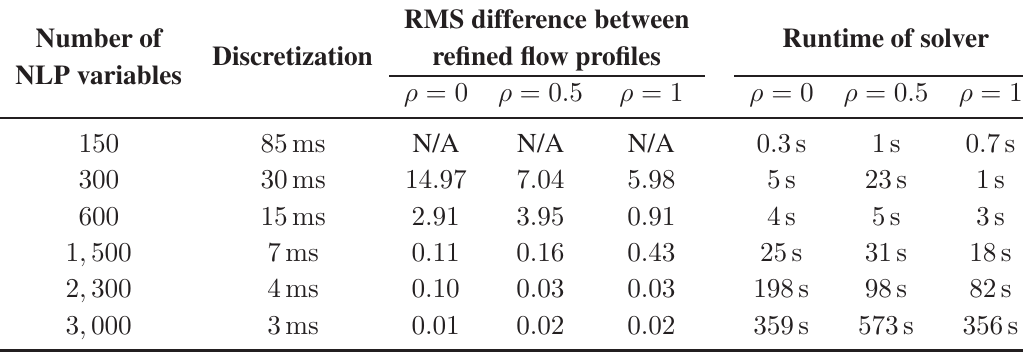
Table 1. Data of panels (a) and (c) of Figure 3.